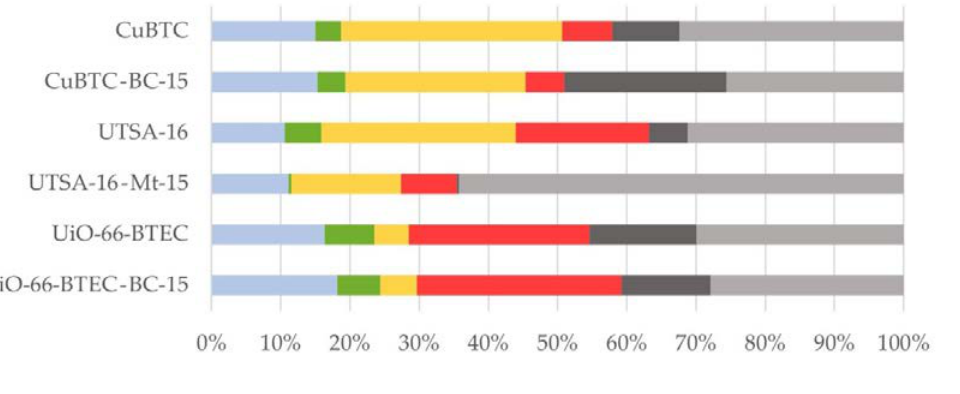
Figure 10. Thermal degradation matrix of MOFs—CuBTC, UTSA-16, UiO-66-BTEC, and MOF-composites—CuBTC-BC-15, UTSA-16-Mt-15, UiO-66-BTEC-BC-15.